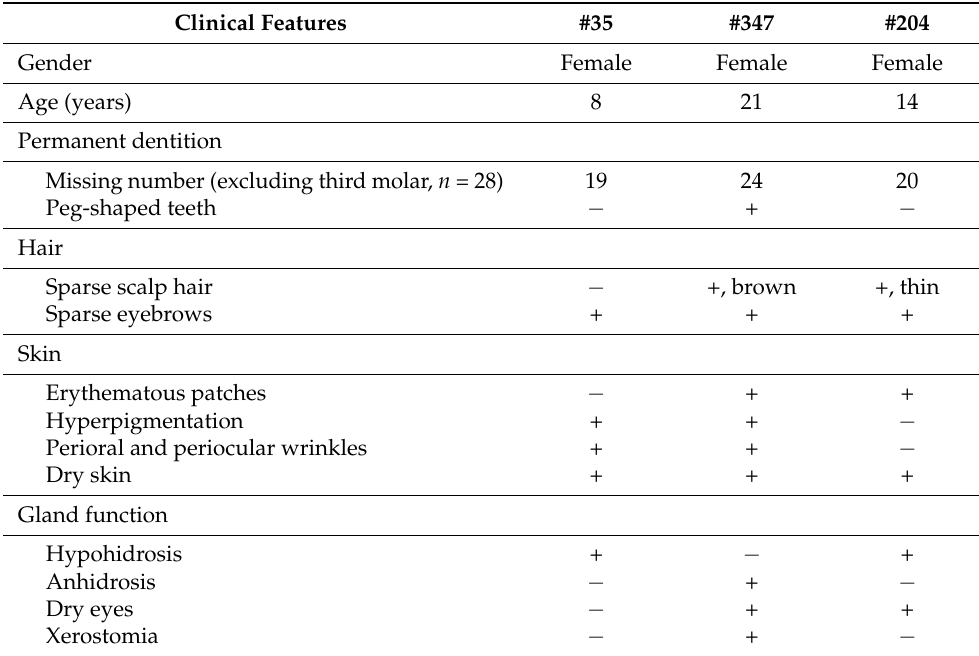
Table 1. Overview of the clinical features of the patients in this